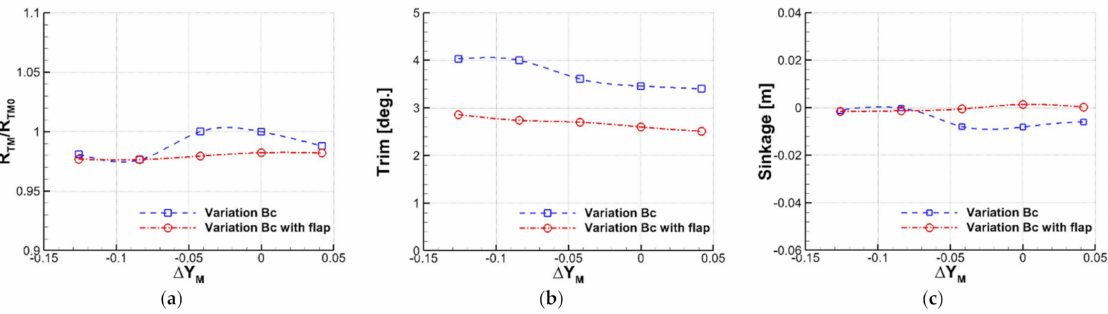
Figure 10. Variation of total resistance, trim, and sinkage depending on design parameter ∆ Y M and stern flap. ( a ) Ratio of total resistance; ( b ) trim; ( c ) sinkage.